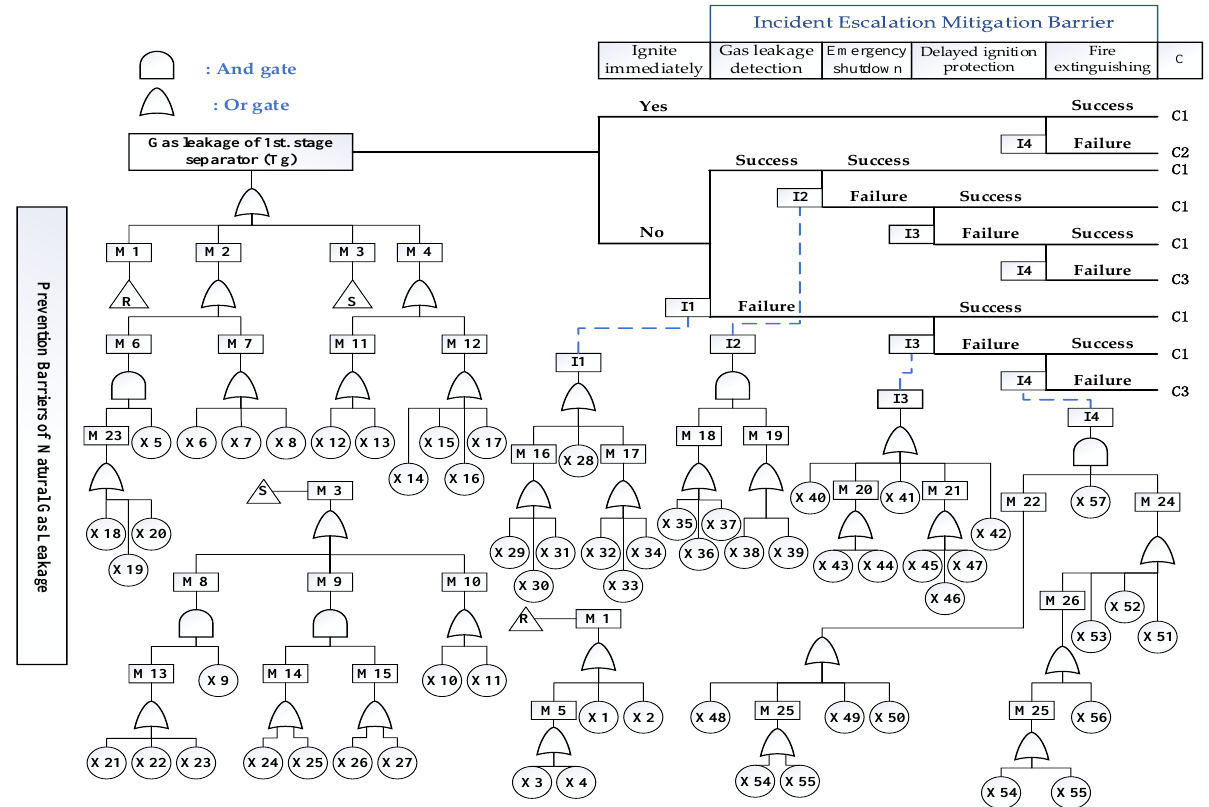
Figure 6. The BT model of gas leakage.